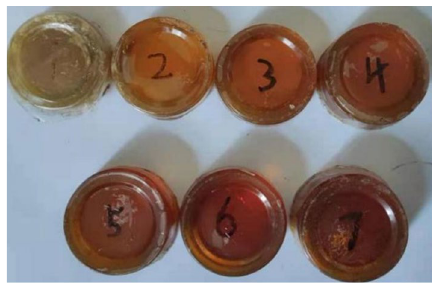
Figure 7. Compressed specimen.